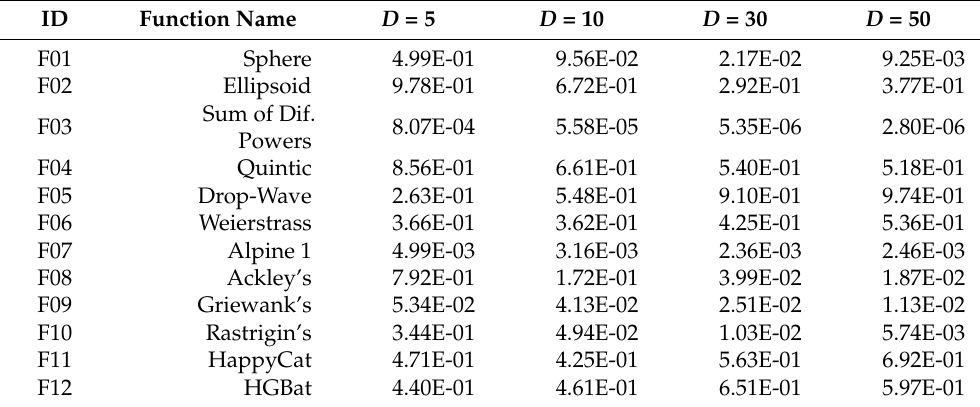
Table 4. Best results * of the PROS algorithm for all 12 objective functions, for D = 5, 10, 30, 50 dimensions (averages of 10 runs). The target (optimum) value is zero in all the cases considered.